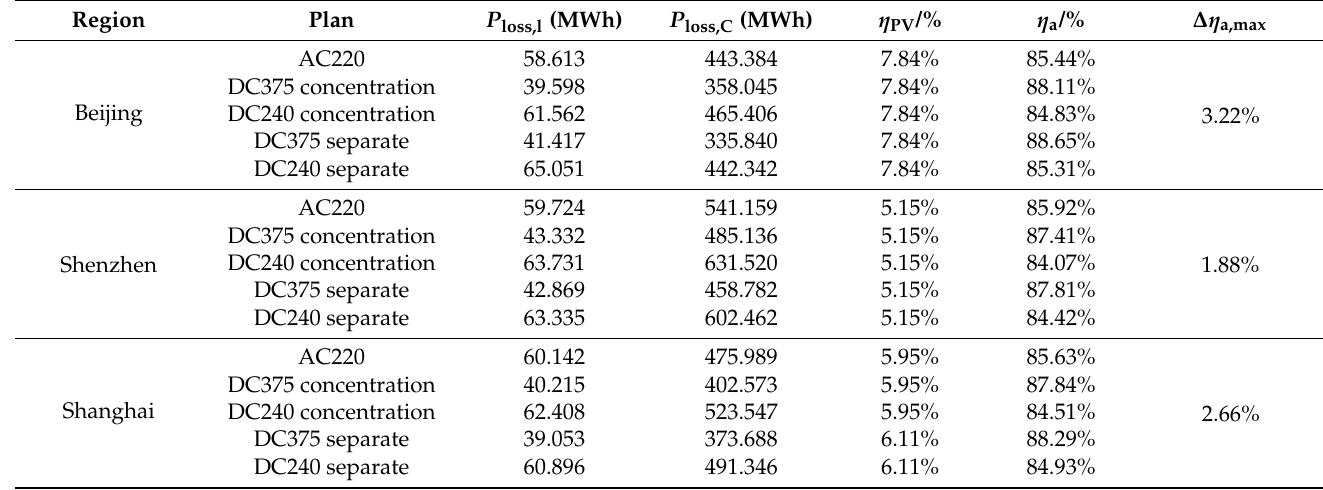
Table A2. Comparison of energy efficiency of hotel buildings with different topologies in three regions.